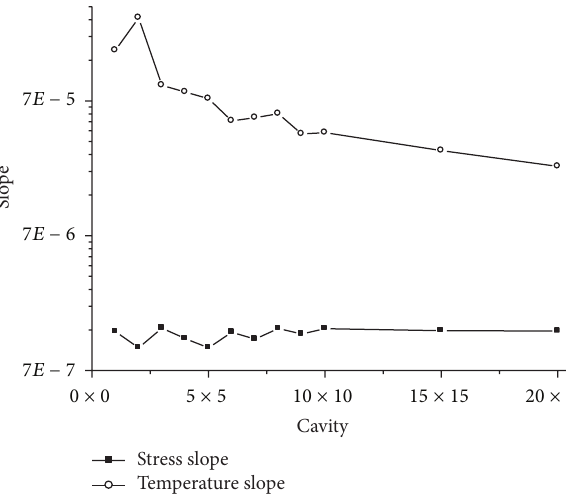
Figure 9: Slopes for the curve between resonant frequency and temperature and between resonant frequency and